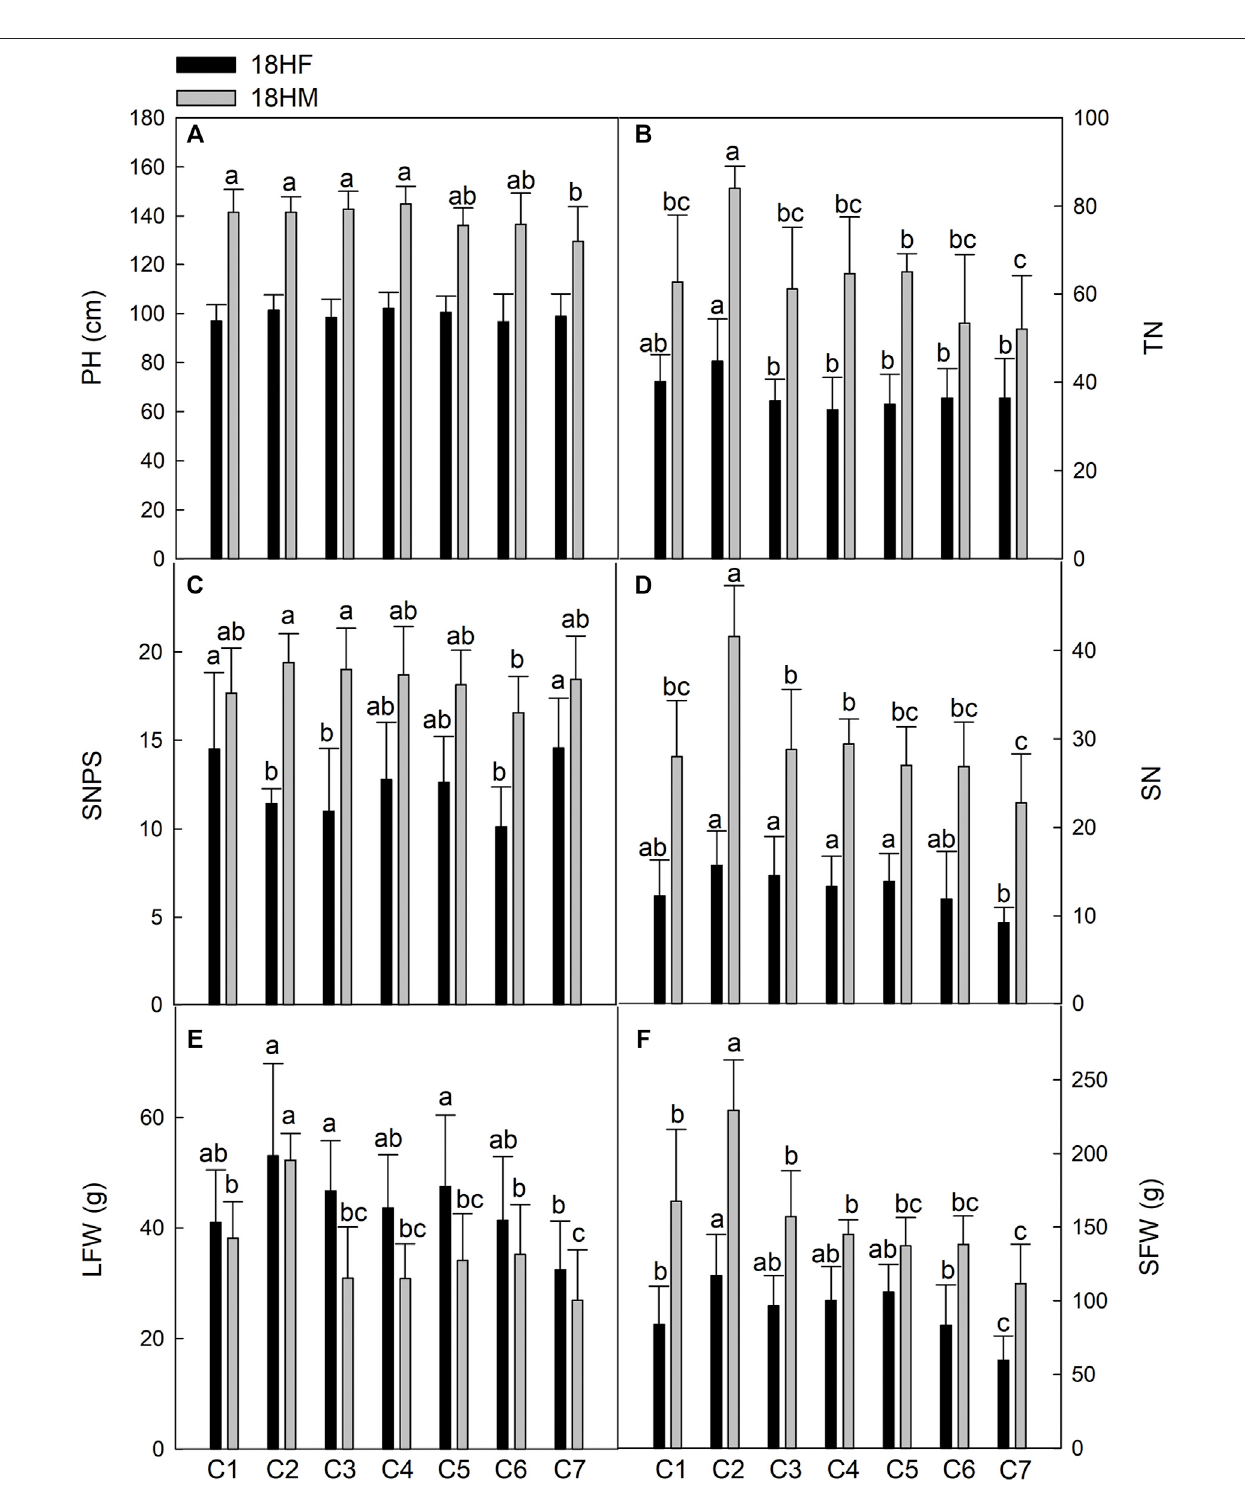
FIGURE 2 | Comparison of main agronomic traits of seven Th. ponticum lines at Haixing station at different growing stages. ( A) Plant height (PH). (B) Tiller number (TN). (C) Spikelet number per spike (SNPS). (D) Spike number (SN). (E) Leaf fresh weight (LFW). (F) Stem fresh weight (SFW). Different letters indicate a signi fi cant difference between seven Th. ponticum lines at p < .05 level.